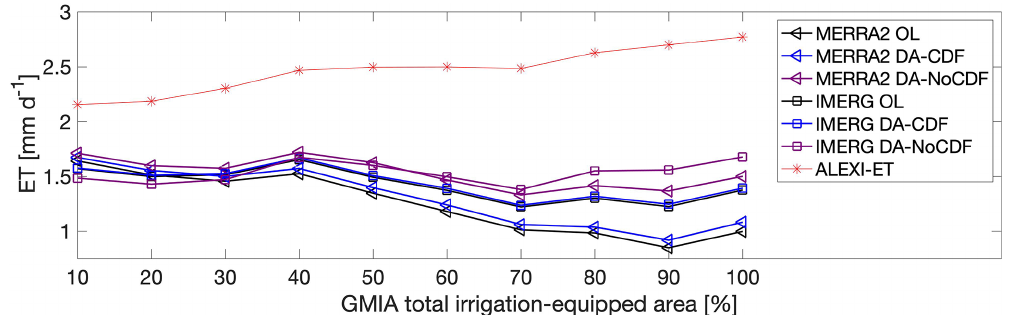
Figure 8. The magnitude of average evapotranspiration (ET) increased as the percentage of irrigated area within the grid cell